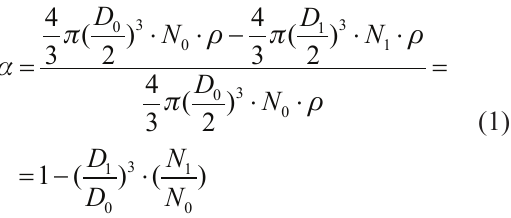
where k 1 and k 2 represent the kinetic constants for the interface nucleation and the surface nucleation, respectively. These constants are a function of temperature and sample characteristics. Integrating Eqs. (3) and (4) from time = 0 (when N 1 = N 0 ) to time t , we